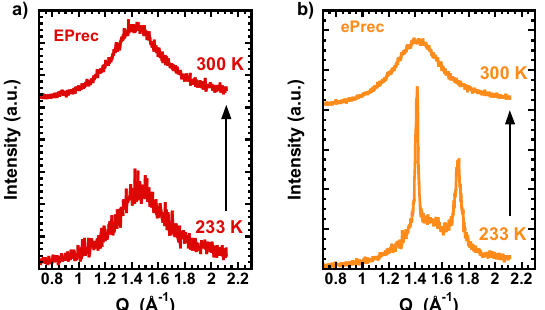
Fig. 2. WAXS measurements at low temperature (233 K) and at room temperature (300 K) for (a) EPrec and (b) ePrec samples after the previous cooling process at 20 K/min.